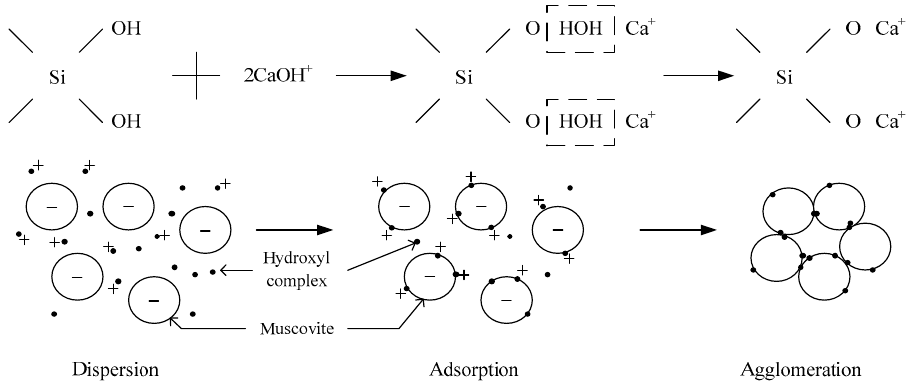
Figure 10. Bridging effect of hydroxy complex.